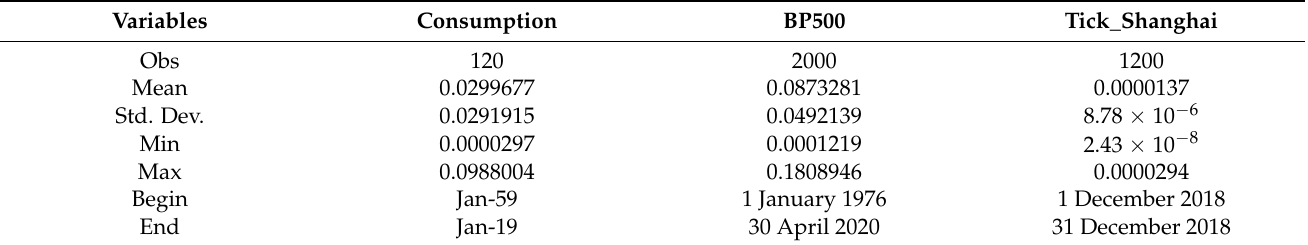
Table 1. Descriptive Statistics.